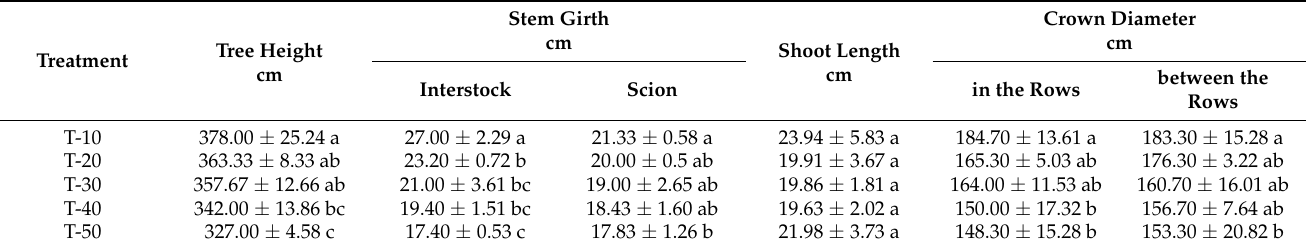
Table 2. Effects of different dwarfing interstock lengths on the growth of apple trees (2020).